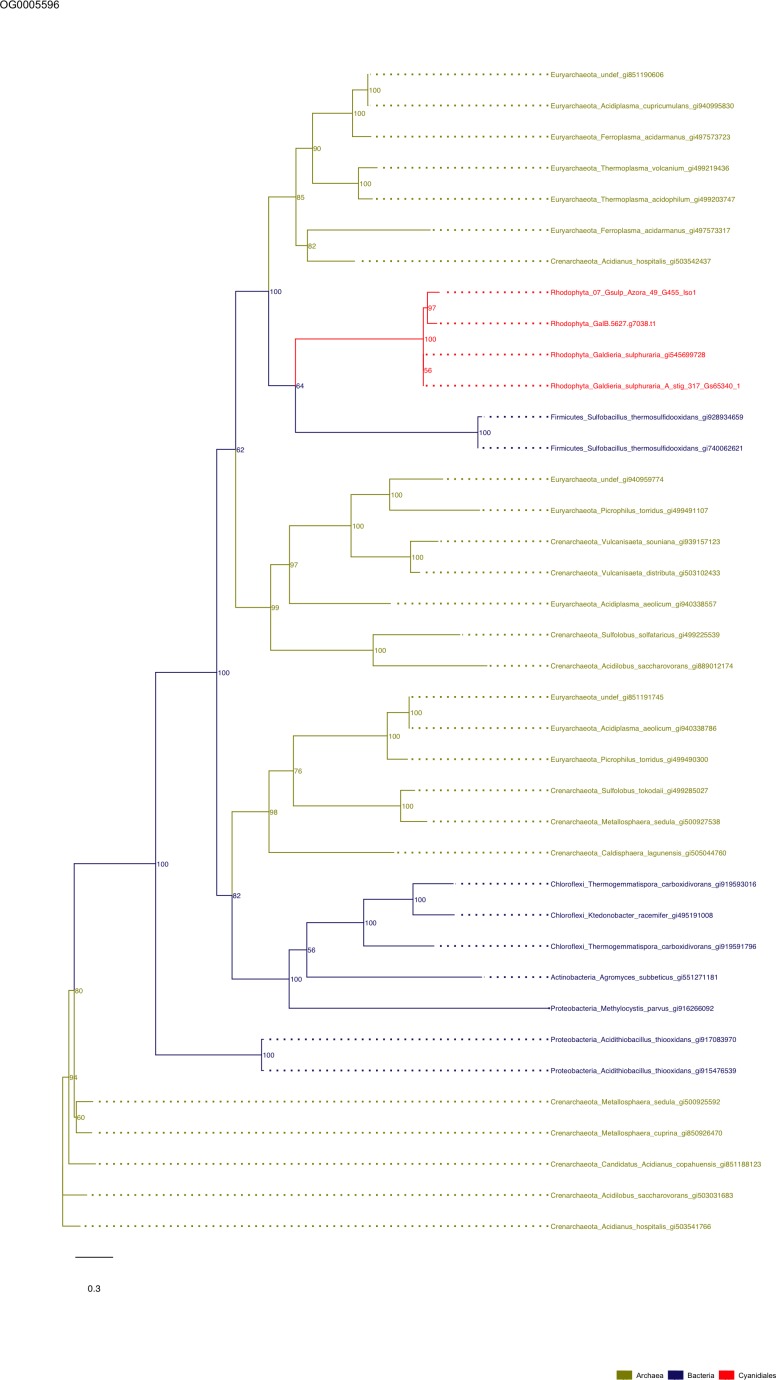
Sequence tree of orthogroup OG0005596.The tree is based on amino acid sequences. Archaea (yellow), Bacteria (blue), Cyanidiales (red), Eukaryotes including other red algae (green). Branches containing Cyanidiales sequences are highlited in red.